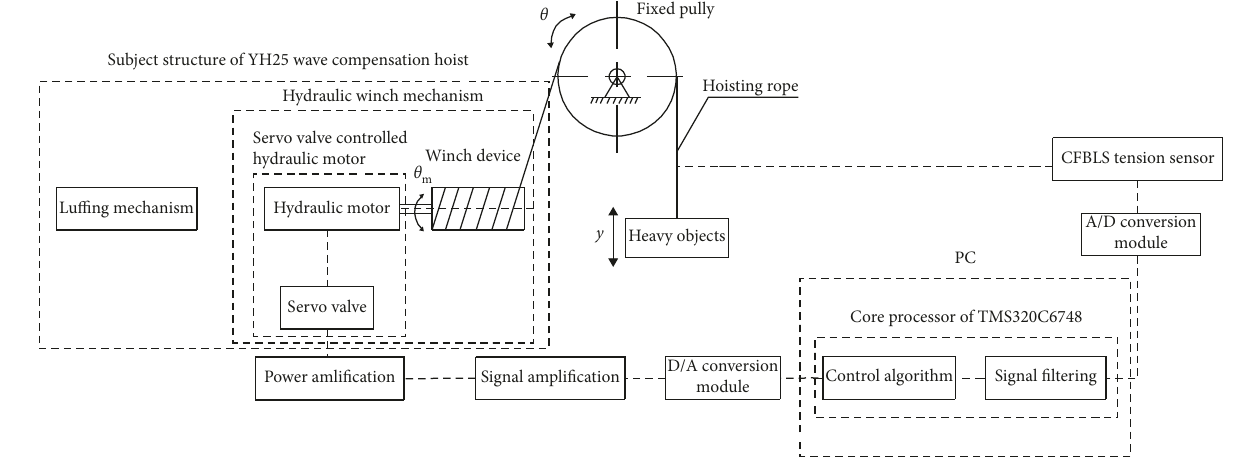
Figure 16: The working system of YH25 wave compensation hoist. Table 2: The experimental parameters [21].